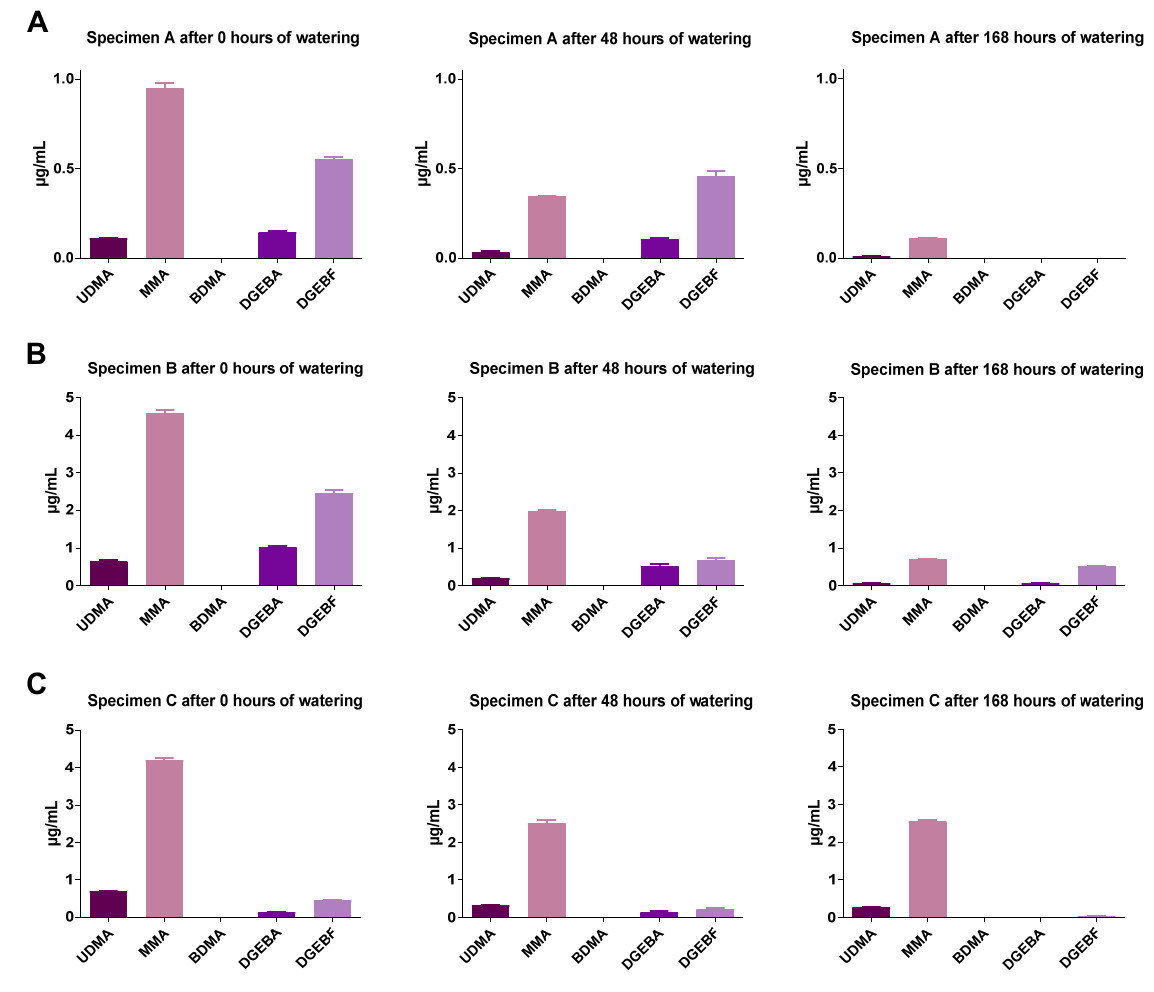
Figure 7. Monomer concentration of Loctite ® EA 9483 specimen extracts of ( A ) test specimens A (15 mm × 0.5 mm), ( B ) test specimens B (50 mm × 1.0 mm) or ( C ) test specimens C (50 mm × 3.0 mm)